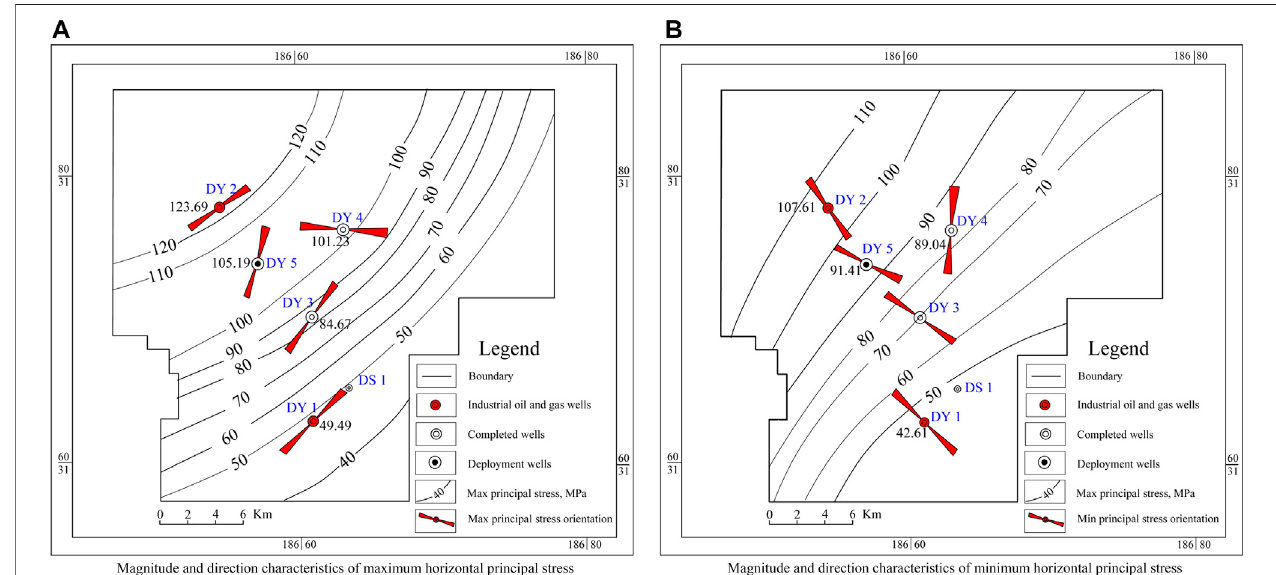
FIGURE 8 | Magnitude and direction distribution of horizontal principal stress in the Longmaxi formation. (A) Magnitude and direction characteristics of maximum horizontal principal stress. (B) Magnitude and direction characteristics of minimum horizontal principal stress.